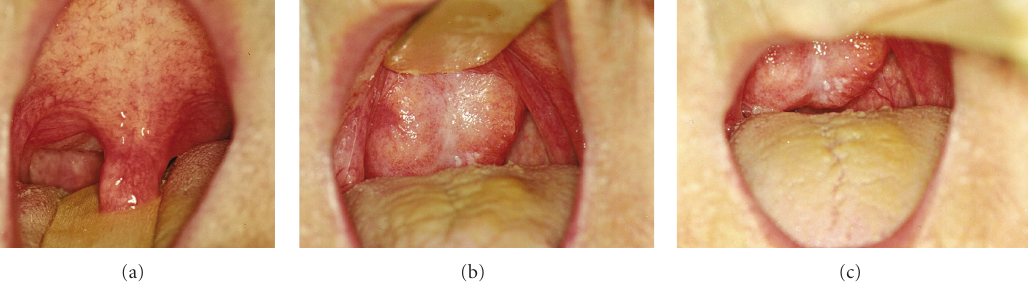
Figure 1: Large nasopharyngeal mass visualised on retraction of soft palate.